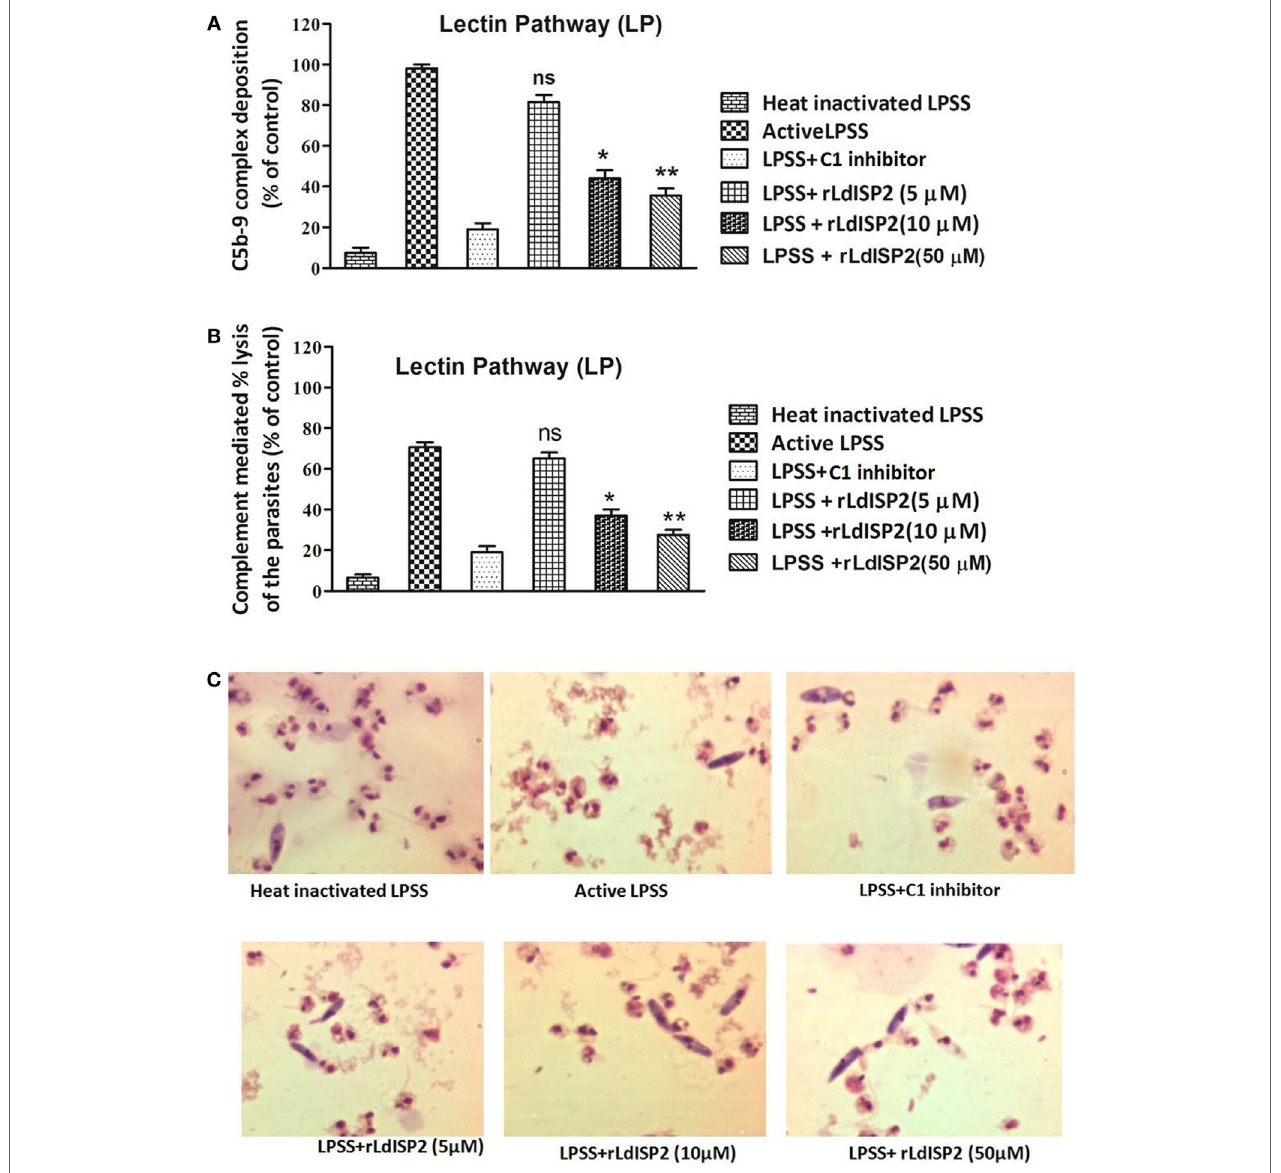
FigUre 6 | Effect of rLdISP2 on membrane attacking complex (MAC) formation and complement-mediated lysis. Lectin pathway (LP) was activated by using lectin pathway specific serum (LPSS). MAC (C5b-9 complex) formation and subsequent parasite lysis was monitored in presence or absence of rLdISP2. Leishmania promastigotes (~1 × 10 7 ) were either treated with heat-inactivated LPSS, active LPSS and LPSS pretreated with C1-inhibitor (10 nM) or rLdISP2 (5–50 µM). The relative formation of C5b-9 complex (a) and complement-mediated lysis ( via LP) (B) was measured by ELISA. LP mediated killing of Leishmania parasites was analysed in presence of rLdISP2. The lysis of the parasites was visualized by optical microscopy (c) . The experiments were performed in triplicate and data are means ± SD from three separate experiments. An asterisk * denotes P ≤ 0.05 and double asterisk ** denotes P ≤ 0.001 when compared to control (Student’s t